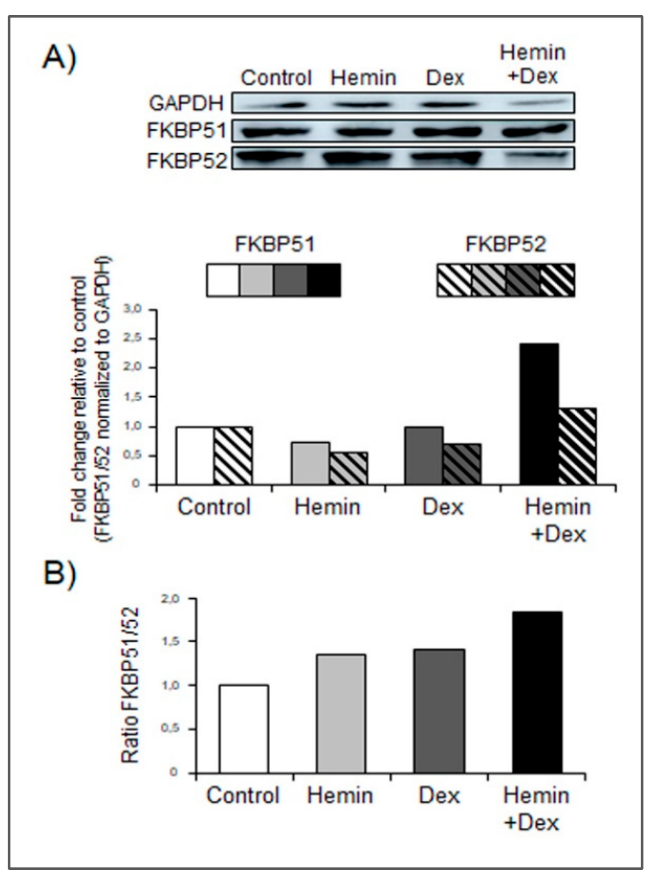
Figure 4. Hemin increases FKBP51 expression under Dexamethasone stimulation. ( A ) Western blot analysis showing FKBP51 and FKBP52 expression in PC3 cells treated with Hemin (80 µ M for 24 h), Dex (10 nM for 6 h post Hemin/PBS 24-h treatment), the combination of both drugs, or PBS as control. Total protein was extracted and protein expression was analyzed by western blotting using specific antibodies. GAPDH levels are shown as control for equal loading. Protein quantification was performed by densitometry analysis using ImageJ software and bands were normalized to GAPDH and control. ( B ) FKBP51/FKBP52 ratio was calculated for each condition. One representative from at least three independent experiments is shown.